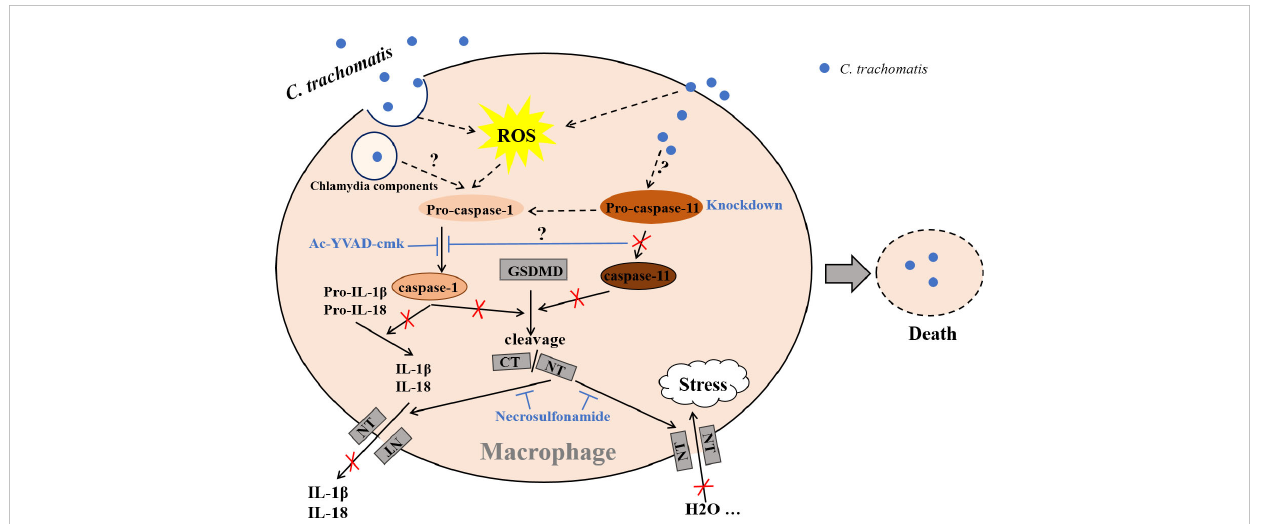
FIGURE 6 Proposed model of chlamydial growth restriction in macrophages by GSDMD-mediated pyroptosis. C. trachomatis is internalized by macrophages after contacting them during infecting host, cleaving GSDMD into GSDMD C-terminus (GSDMD-CT) and GSDMD-NT via activating caspase-1/11. GSDMD-NT could insert itself into the cell membrane to form pores. H2O in fl ux leads to an increase in intracellular osmotic pressure, then causing cell swelling and rupture, destroying the replication niche of C. trachomatis to restrict its growth in macrophages. Active caspase-1 cleaves Pro-IL-1 b and Pro-IL-18 into mature IL-1 b and IL-18. Both are then released into the outside of cells during pyroptosis. Caspase-1 activation inhibition with Ac-YVAD-cmk blocks IL-1 b and IL-18 mature and GSDMD cleavage. Caspase-11 knockdown inhibits both GSDMD activation and caspase-1 activation. Necrosulfonamide restrains treatment GSDMD-NT oligomerization and pyroptotic pore formation, inhibiting IL-1 b and IL-18 secretion and H2O in fl ux. Dashed lines represent published pathways, solid lines represent pathways described in this study. It is currently unknown what C. trachomatis components activate caspase-1 or caspase-11 (not by Chlamydia LPS). It is unclear how caspase-11 signal pathway interacts with caspase-1 signal